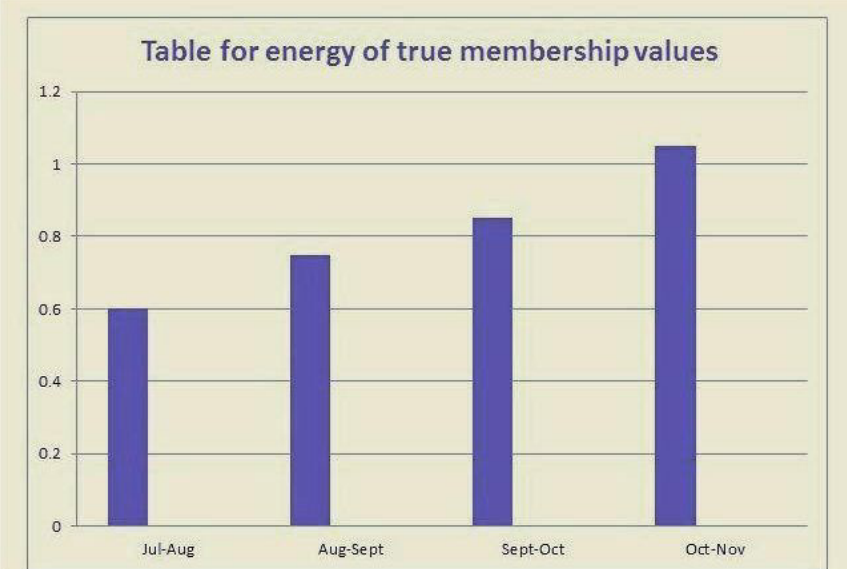
Figure 17. Energy of true membership